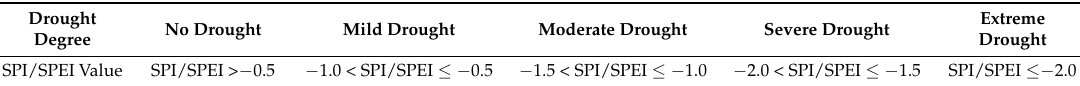
Table 1. Drought degrees based on the standardized precipitation evapotranspiration index (SPEI). SPI—standardized precipitation